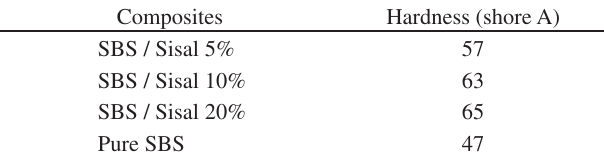
Table 1. Hardness of the SBS/long sisal fiber composite and pure